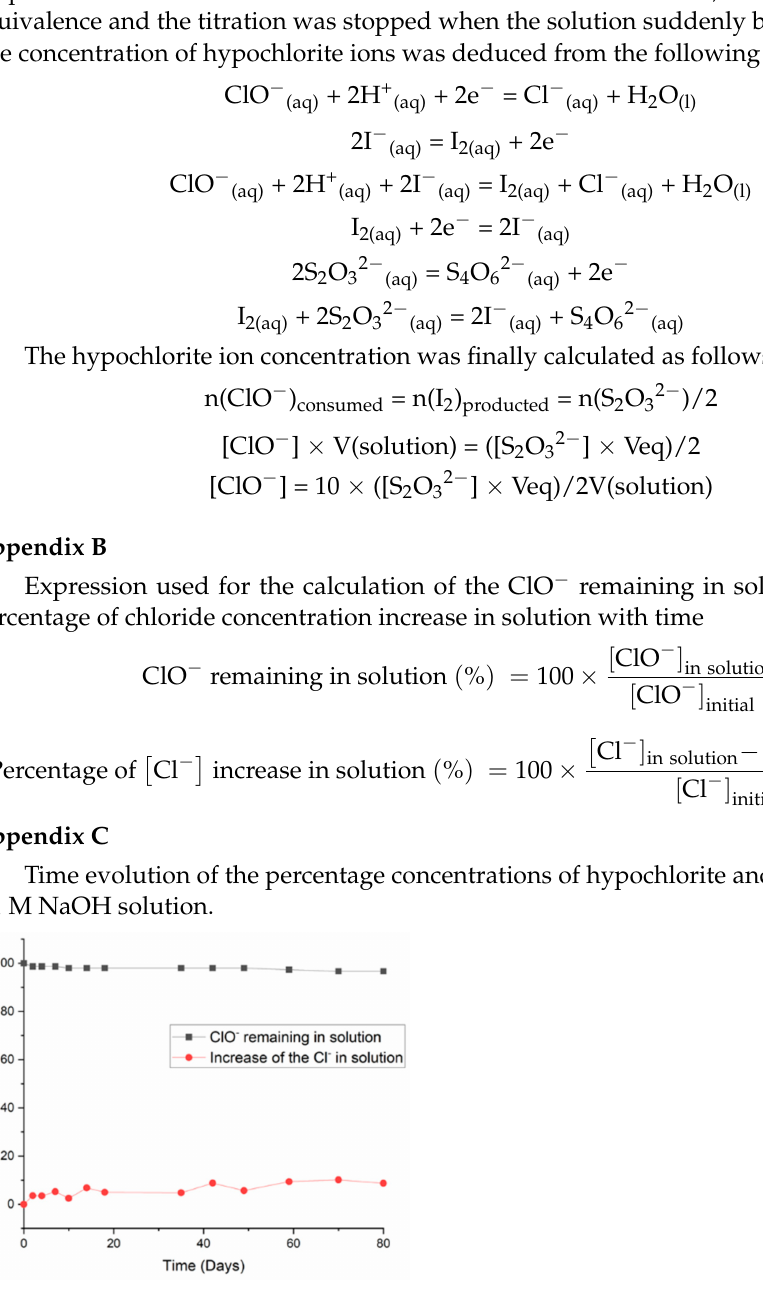
Figure A1. Concentrations of hypochlorite and chloride ions as a function of time in a 1 M NaOH solution, expressed as percentages of the initial